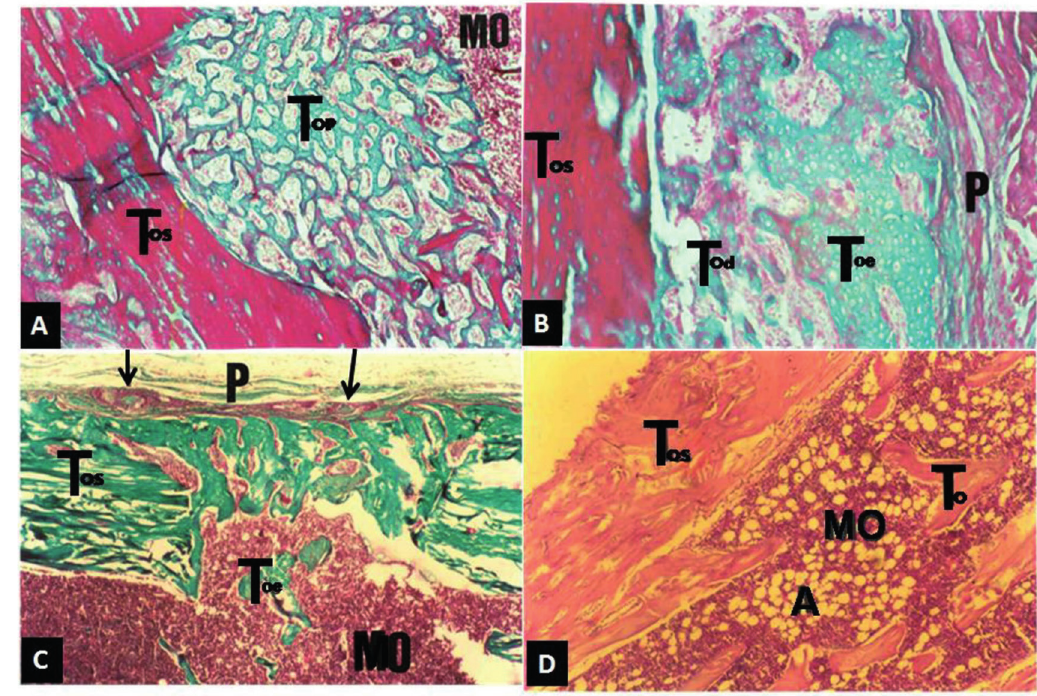
Figure 1 - Control Group. A. Longitudinal section of part of the diaphysis of rats after 5 days of osteotomy. The deepest portion of the osteotomy hole (cross-section) is filled with primary bone (Top), toward the bone marrow; secondary bone diaphyseal (Tos); Bone marrow (BM); Masson. 160X. B. Longitudinal section of rat after osteotomy (10 days). thick and fibrous periosteum (P); periosteal bone callus with thick trabeculae (Toe) and delicate (Tod); secondary bone diaphyseal (Tos). Masson. 40X C. Longitudinal section of diaphysis of rats after osteotomy (20 days). Periosteum (P) with trabeculae remains (arrow); second- ary bone diaphyseal (Tos); trabeculae of endosteal bone (Tce); Bone marrow (BM). Masson. 20X. D. Diaphysis rat cut after osteotomy (30 days). secondary bone diaphyseal (Tos); bone trabeculae (To) within the bone marrow (MO), adipocytes (A). Hematoxylin and eosin.